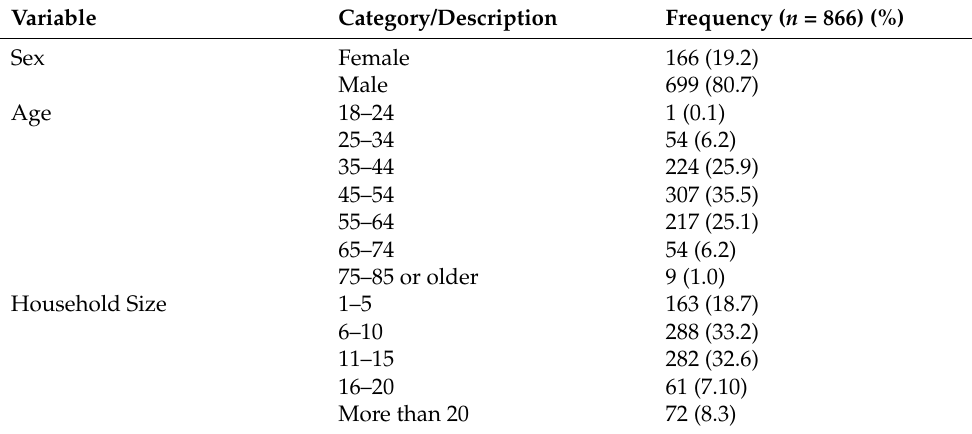
Table 2. Socio-demographic characteristics of respondents. Household size was on a 21-point scale, (1 = “1” to 21 = “More than 20”): Mean = 10.70, SD =